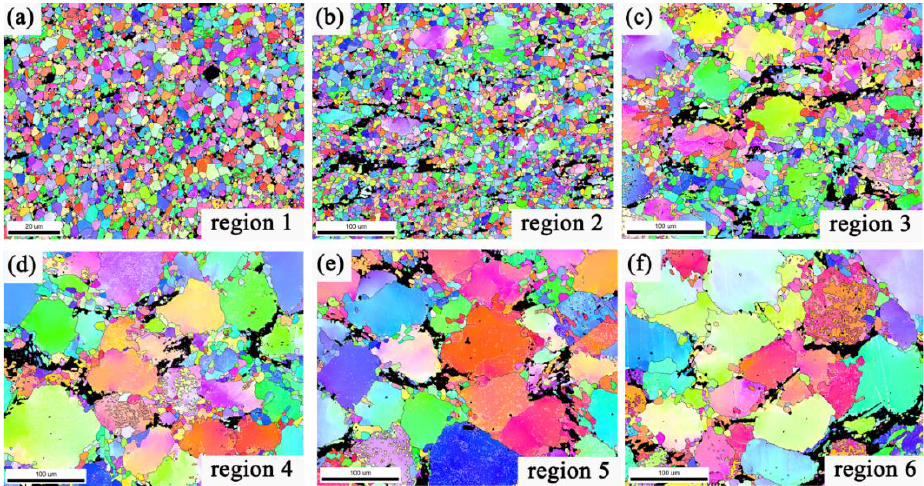
Figure 5. The EBSD maps of the cross-section in the different zones along RD, ( a ) region 1, ( b ) region 2, ( c ) region 3, ( d ) region 4, ( e ) region 5, ( f ) region 6.